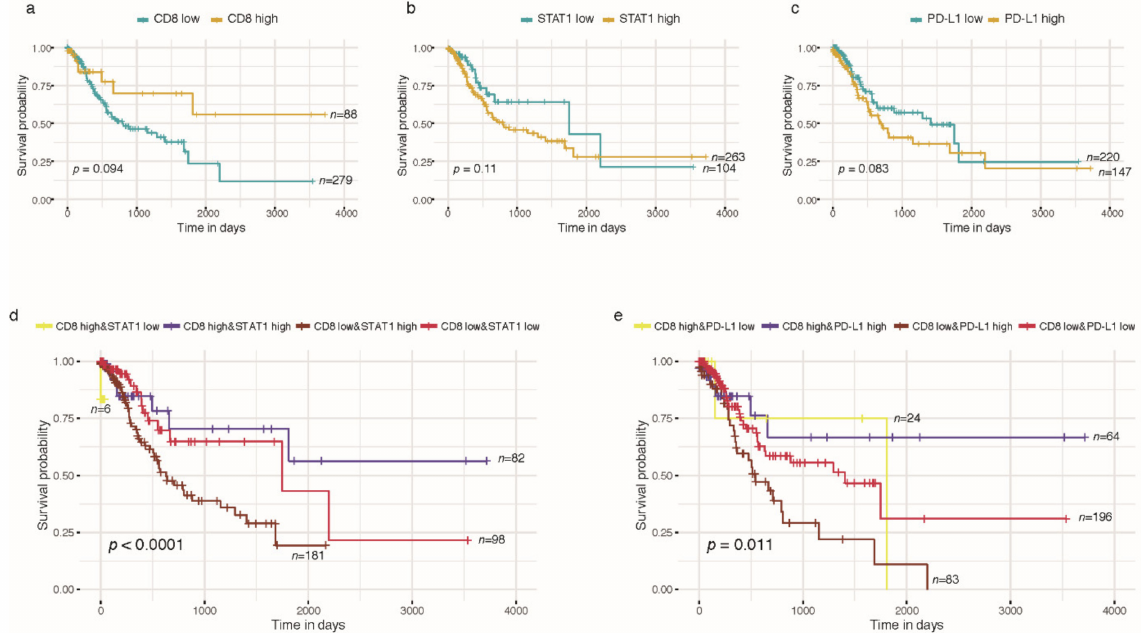
Figure 4. Kaplan-Meier curves of CD8+ T cell immune infiltration, STAT1 and PD-L1 in TCGA-STAD prognosis analysis. ( a ) CD8+ T cell immune infiltration; ( b ) STAT1; ( c ) PD-L1; ( d ) CD8+ T cell immune infiltration combined STAT1; ( e ) CD8+ T cell immune infiltration combined PD-L1. Log rank test for p